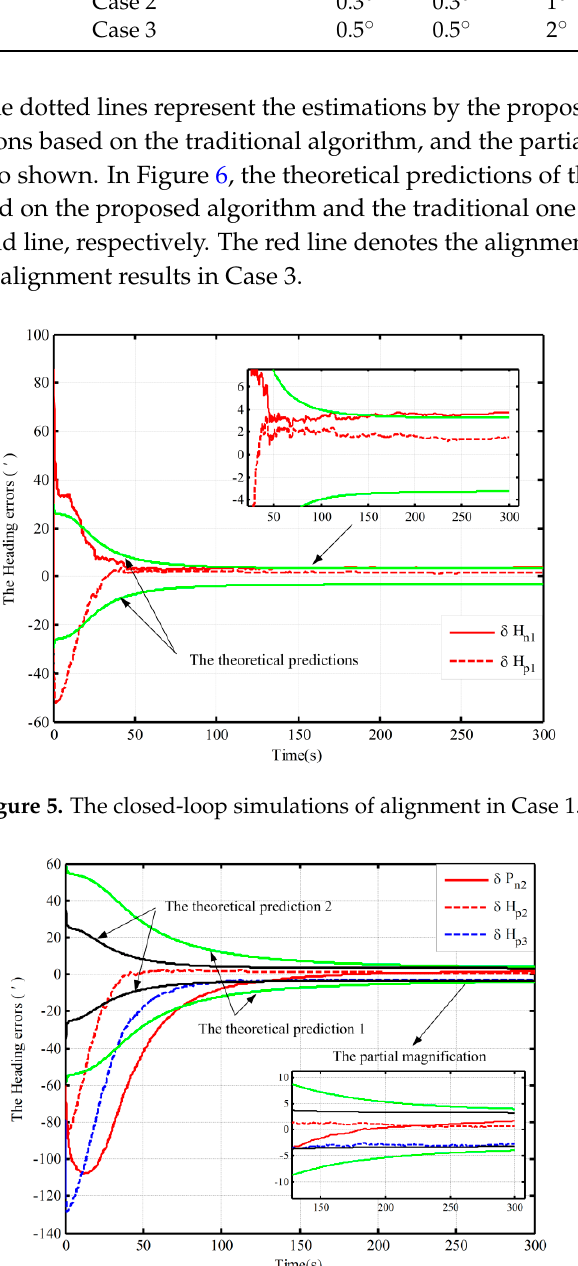
Figure 6. The closed-loop simulations of alignment in the other two cases.